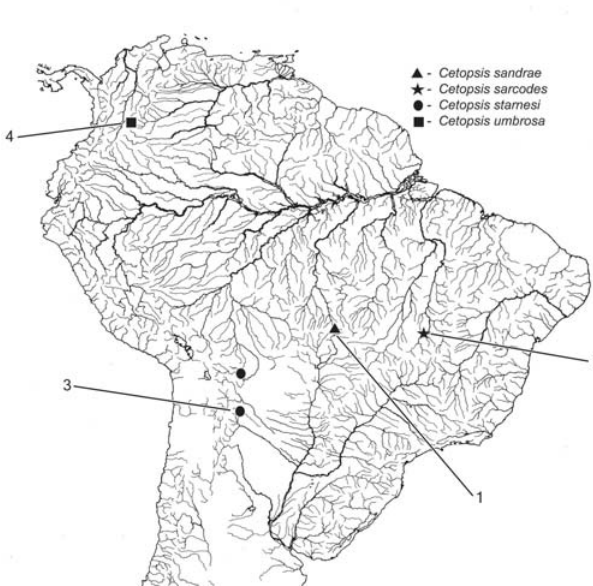
Fig. 41. Map of central and northern South America showing geographic distribution of Cetopsis sandrae (1 = holotype locality), Cetopsis sarcodes (2 = holotype locality), Cetopsis starnesi (3 = holotype locality), and Cetopsis umbrosa (4 = holotype locality) (some symbols represent more that one locality and/or lot of Coloration in alcohol. Dark pigmentation covering dorsal portion of head from tip of snout to posterior margin of head. Dark, dorsal pigmentation continuous with dark region posterodorsal and posterior to orbit. Remaining portions of head pale. Dorsal portion of body dark. Lateral surface of body irregularly covered with fine, dark spots; spots often coalesce into eye-size blotches, with such coalescence more prevalent ventral of lateral line. Heavily pigmented individu- als with lateral surface of body nearly uniformly dark. Ventral surface of body pale, with few, scattered, dark spots present only in most heavily pigmented individuals.